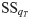
Parameter estimates from the serotype-specific models.(a) Density estimates for serotype-specific viral infectivity rates β for model SSβ. (b) Density estimates for serotype-specific innate immune response activation rates for model SSq. (c) Density estimates for serotype-specific T-cell activation rates qT for model SSqT. (d) Density estimates for serotype-specific viral infectivity rates β for model SSβ that was fitted to only the subset of the viral load data with individuals with a detected viral peak. The median parameter estimate and 95% posterior credible interval (in parentheses) of the difference of the parameter estimates shown in (a-d) relative to DENV-1 are: (a) β2 − β1: 6.6 × 10−11(3.6 × 10−11, 1.1 × 10−10), β3 − β1: 6.4 × 10−11(3.1 × 10−11, 1.1 × 10−10). (b) q2 − q1: 5.2 × 10−5(−1.5 × 10−4, 4.1 × 10−4), q3 − q1: −1.3 × 10−4(−3.1 × 10−4, 8.0 × 10−5). (c) qT2−qT1: 6.1 × 10−7(1.3 × 10−7, 2.2 × 10−6), qT3−qT1: 9.3 × 10−7(3.0 × 10−7, 2.3 × 10−6). (d) β2 − β1: 9.1 × 10−11(4.8 × 10−11, 1.5 × 10−10), β3 − β1: 7.5 × 10−11(1.8 × 10−11, 1.6 × 10−10).